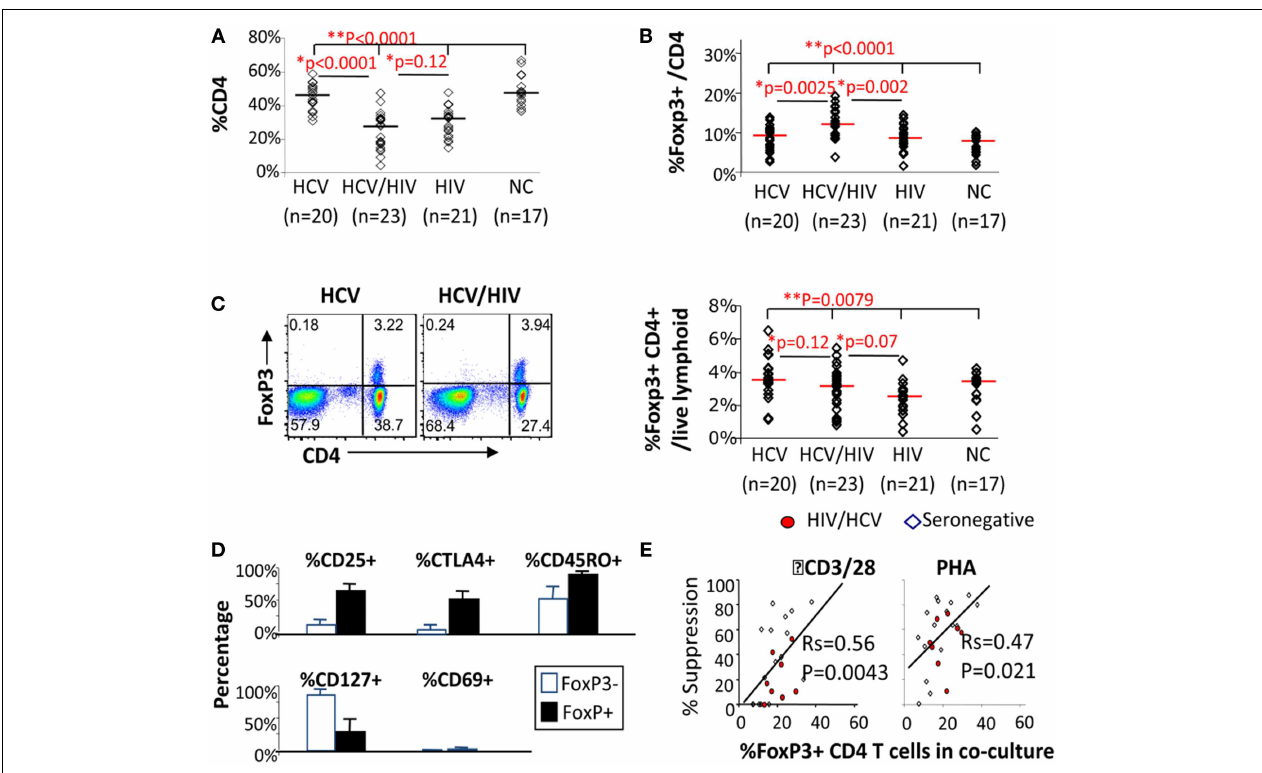
between 20 HCV-monoinfected (HCV), 23 HCV/HIV-coinfected (HCV/HIV), 21 HIV-monoinfected (HIV), and 17 seronegative control (NC) subjects. Horizontal bars indicate median values. P -values are calculated with non-parametric Kruskal–Wallis for comparison between all four groups and Mann–Whitney U for pair-wise comparisons.Two-way comparison of HCV/HIV coinfection group with HCV or HIV monoinfection group was made using non-parametric Mann–Whitney U and corrected for multiple comparisons. (D) Phenotype of FoxP3 + CD4T cells (filled black bars) and FoxP3 − CD4T cells (unfilled bars) from HCV/HIV-coinfected patients are compared using percentage of cells expressing CD25, CTLA-4, CD45RO, CD127, and CD69. (E) Percent suppression of proliferation in AutoMACS-sorted CD4 + CD25 − “responder”T cells alone and with increasing proportion of autologous CD4 + CD25 + “suppressor”T cells enriched for FoxP3 + CD4T cells upon in vitro stimulation with anti-CD3/CD28 or phytohemagglutinin (PHA) followed by 3H thymidine uptake. Proliferation was expressed as a stimulation index (SI): the mean cpm in stimulated wells divided by the mean cpm in unstimulated wells.T cell proliferation in each coculture was normalized by proliferation in CD4 + CD25 − T cells alone and compared to the calculated percentage of FoxP3 + CD4T cells in each coculture condition, based on %FoxP3 + cells in CD4 + CD25 − and CD4 + CD25 + cell subsets determined by